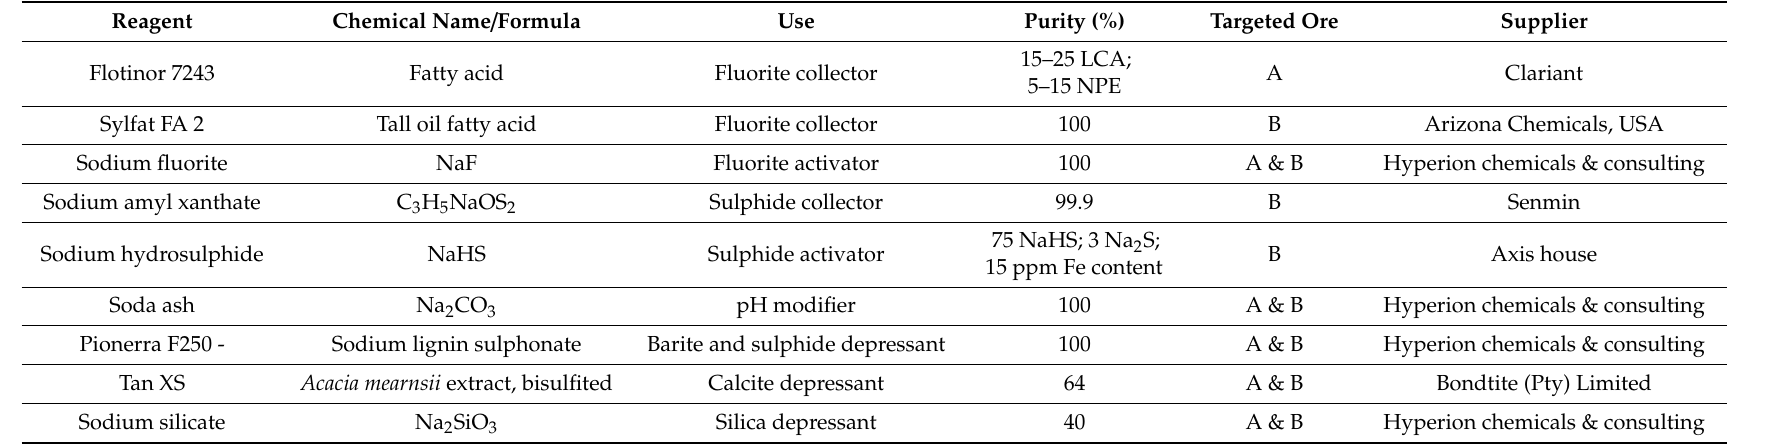
Table 1. List of reagents used in this